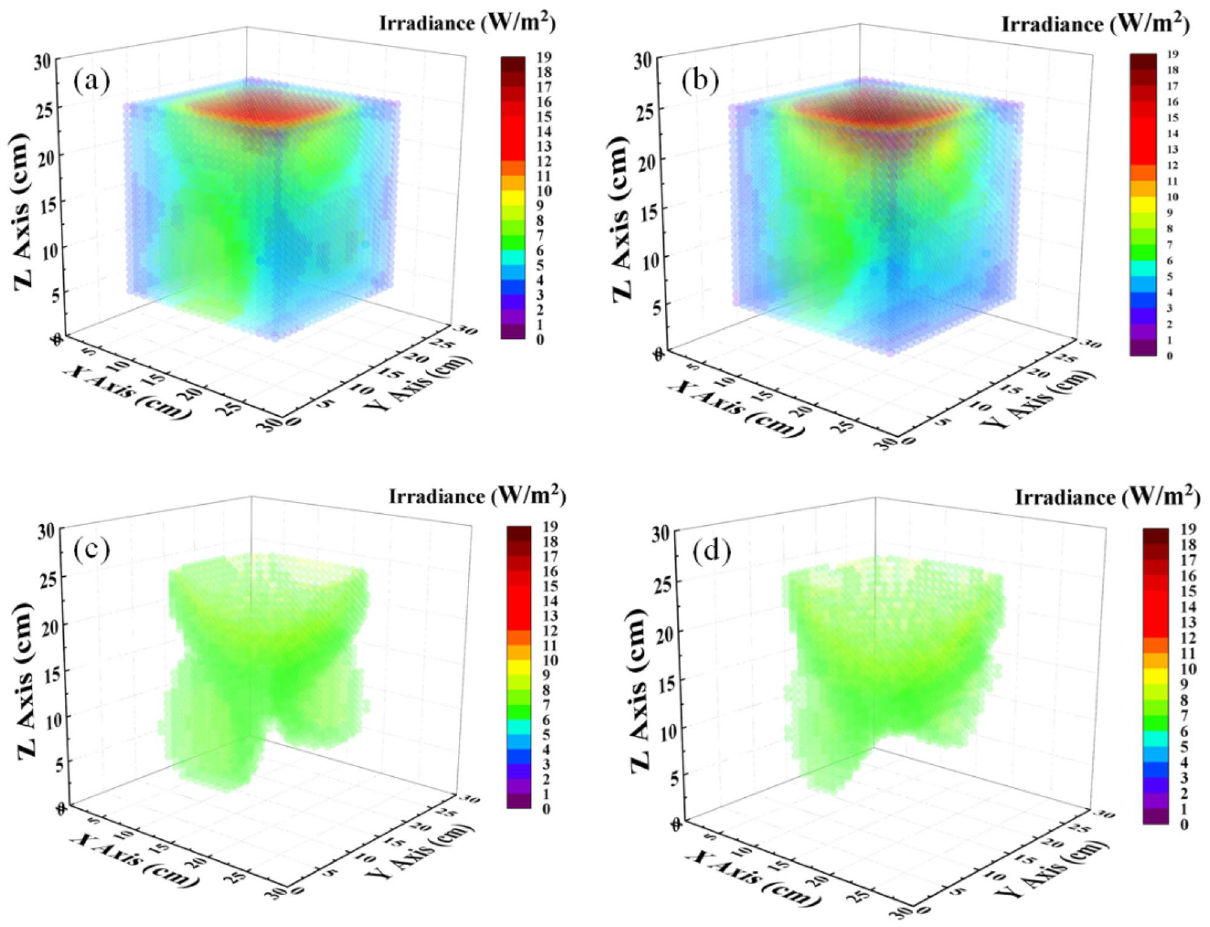
Figure 7. Irradiance distribution of multi-section inside the box in ( a ) simulation and ( b ) experiment; the filtered irradiance distribution with a range from 6 to 9 W/m 2 in ( c ) simulation and ( d ) experiment.